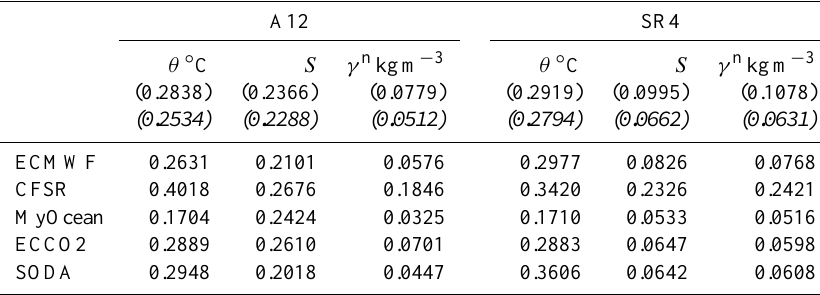
Figure 4. Section WOCE A12. Representation of the time-averaged in situ data and the differences between the reanalyzed and observed data for θ . ECMWF, CFSR, MyOcean, ECCO2, and SODA results are indicated in each figure. The upper 500m is expanded to show more detail. Table 3. RMSE results used to evaluate the accuracy of the reanalyses, as established by Heuzé et al. (2013). The mean RMSEs of the five reanalyses assessed are in parentheses, and the mean RMSEs, considering all products except CFSR, are in italics. Reanalyses that have an RMSE lower than the mean RMSE are considered accurate in the